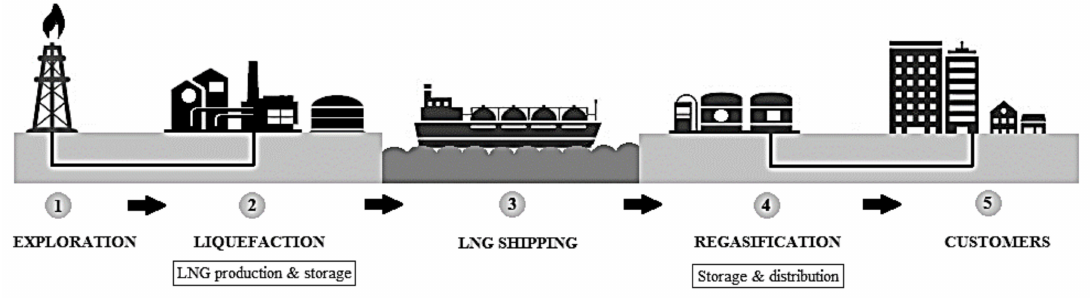
Figure 1. LNG usage